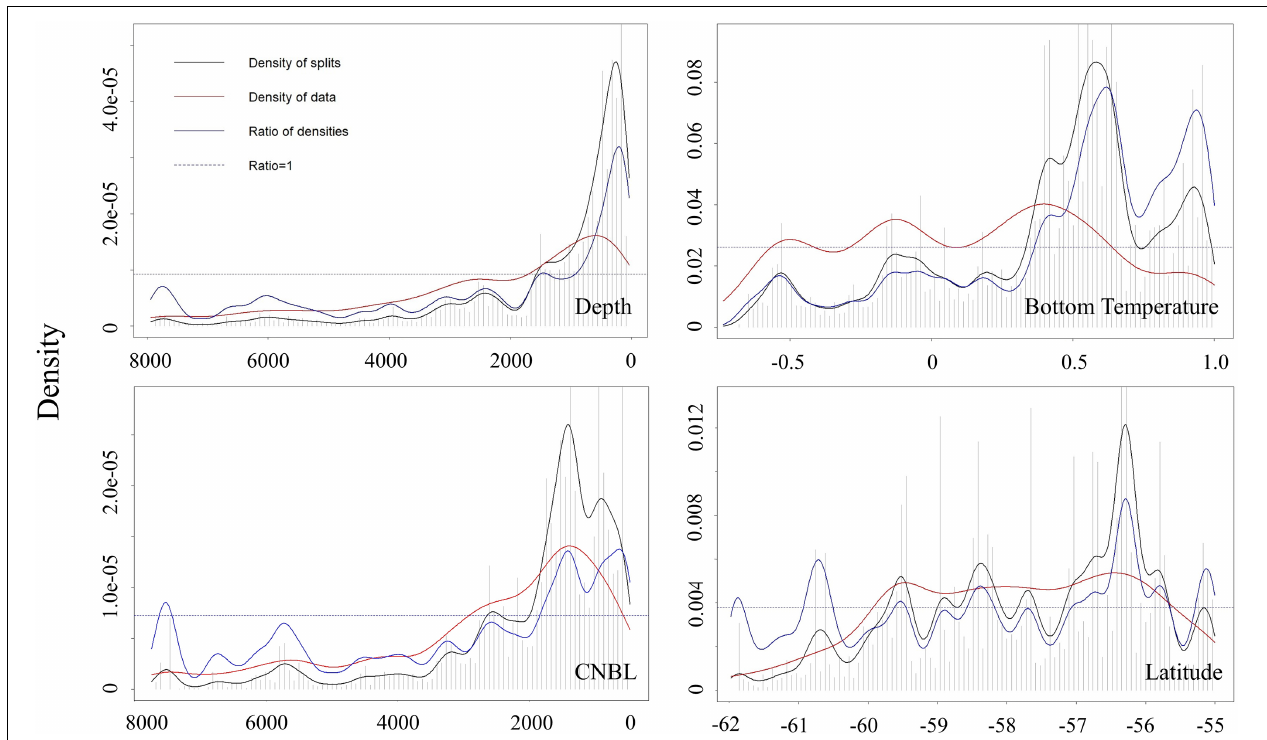
FIGURE 6 | Kernel density plot of random forest tree splits across environmental gradients for the four most important predictors–depth, bottom temperature, channel network base level (CNBL), and latitude. A high density of splits indicates relatively large changes in functional group composition. Split density is denoted by the histogram and black line. Density of sampling is shown in red. The ratio of splits standardised by the sampling density is shown in blue, with ratios > 1 (horizontal dashed line) indicating locations of relatively greater change in